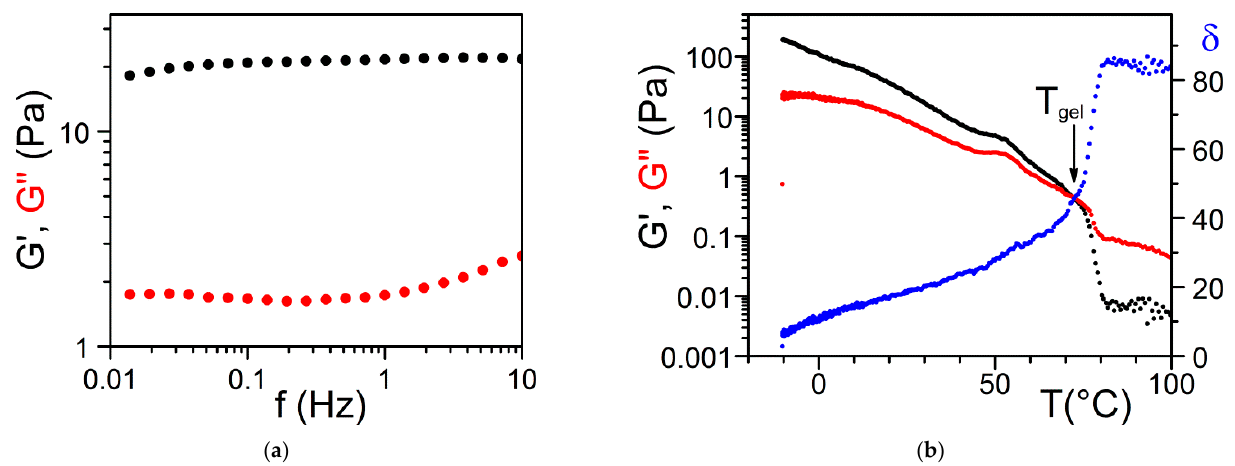
Figure 15. Tri-aryl triamine gels in bromobenzene; ( a ) Variation of G ’ and G ” as a function of frequency at T = 20 °C. ( b ) Variation of G ’, G ” and δ as a function of temperature for a frequency of 1 Hz [28].